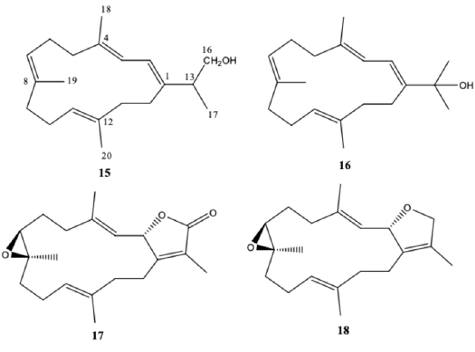
Figure 2. Cembranoid diterpenes isolated from Sarcophyton sp., collected at the Karah Island (West Malaysia) [21].